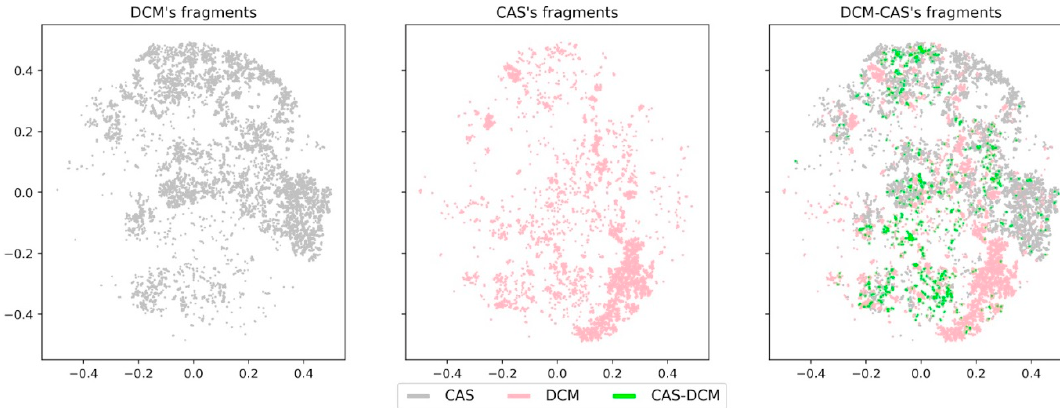
Figure 11. Visualization of the chemical space from CAS fragments (pink), DCM fragments (gray), and overlapping DCM-CAS fragments (green).